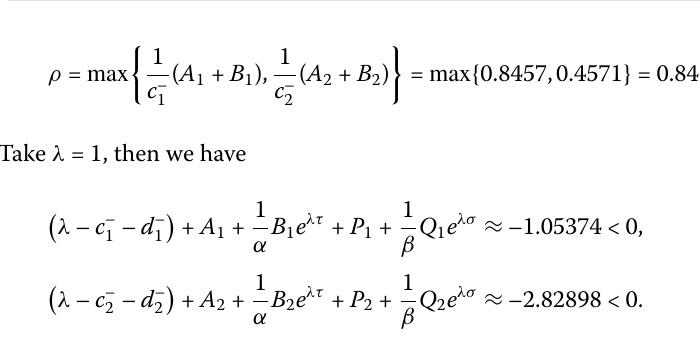
Figure 3 The states of four parts of y 1 ( t ) and y 2 ( t